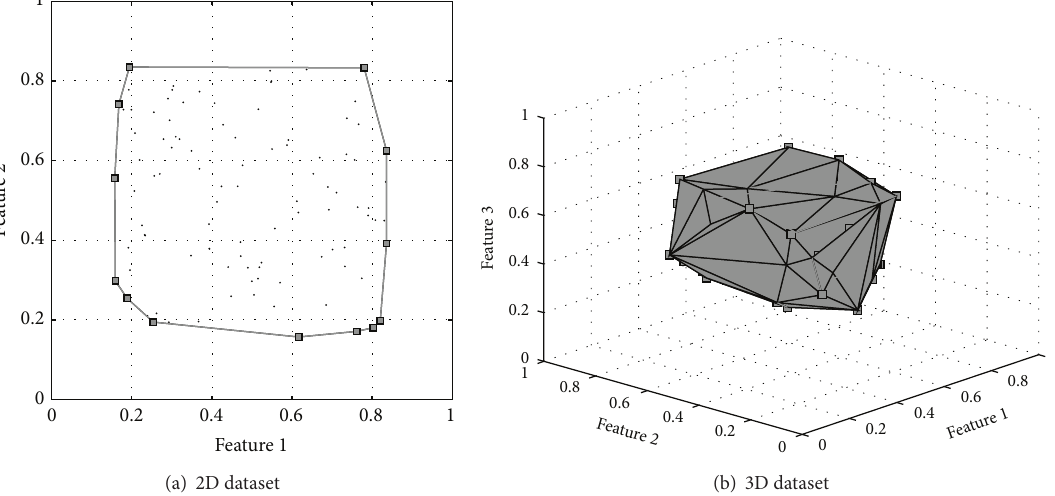
Figure 1: Some examples of convex hull for 2D and 3D datasets; the Quickhull algorithm is applied to determine the convex hulls.